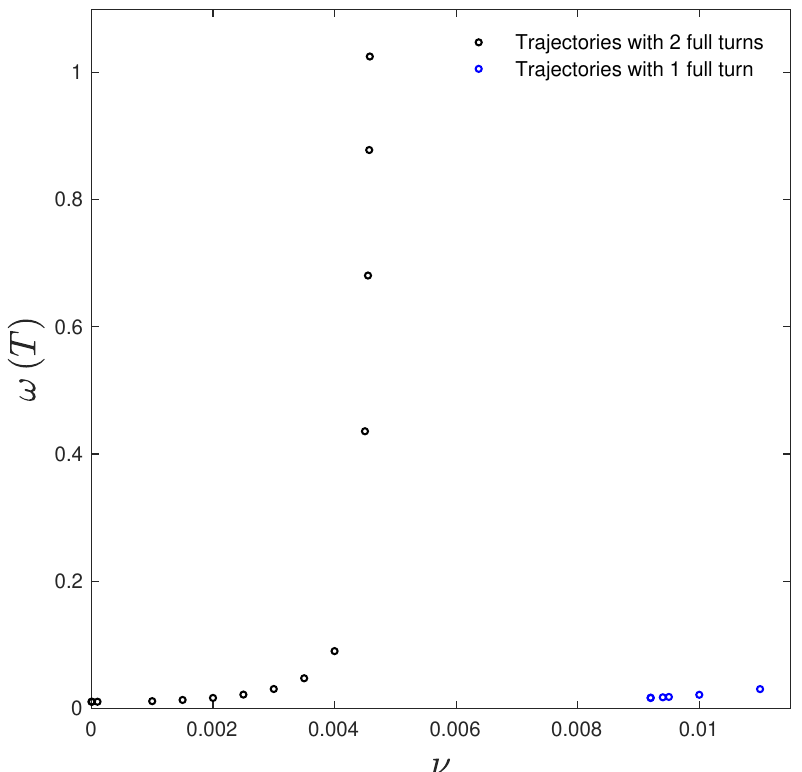
√ √ 2 m, ρ T = 2 m, θ 0 = θ T = π /4,